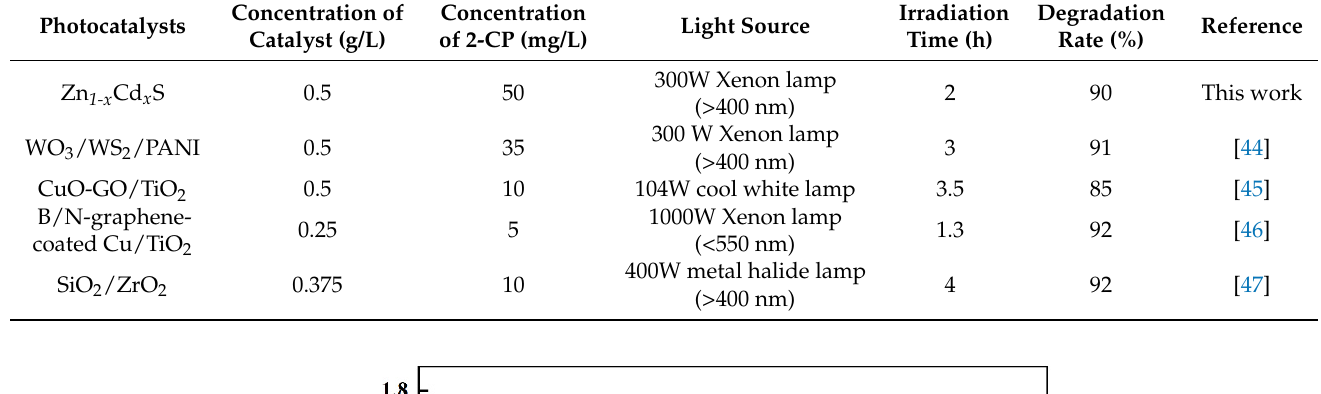
[43] Table 2. Comparison of the performance of different photocatalysts for the degradation in 2-CP. Photocatalysts Concentration of Catalyst (g/L)